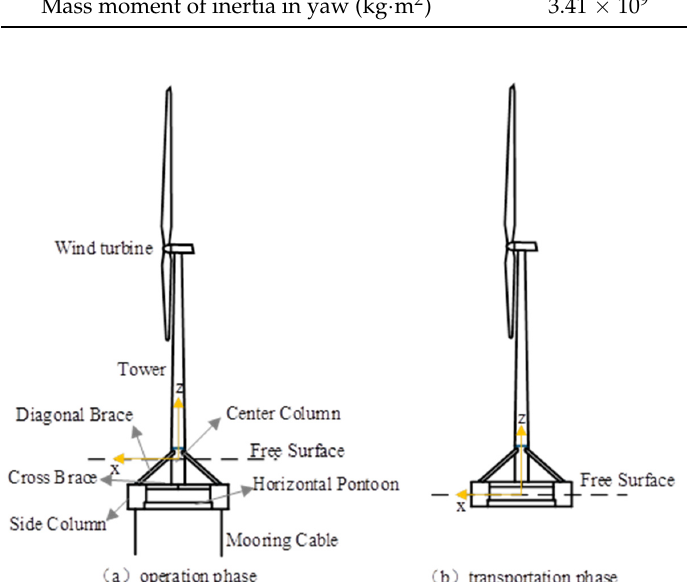
Figure 2. The structure of the SFOWT.